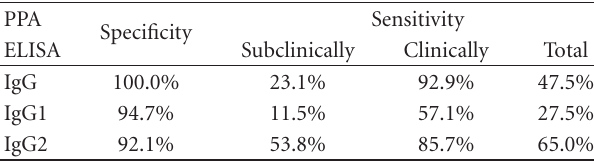
Table 3: Specificity and sensitivity of isotypes/PPA-ELISAs.